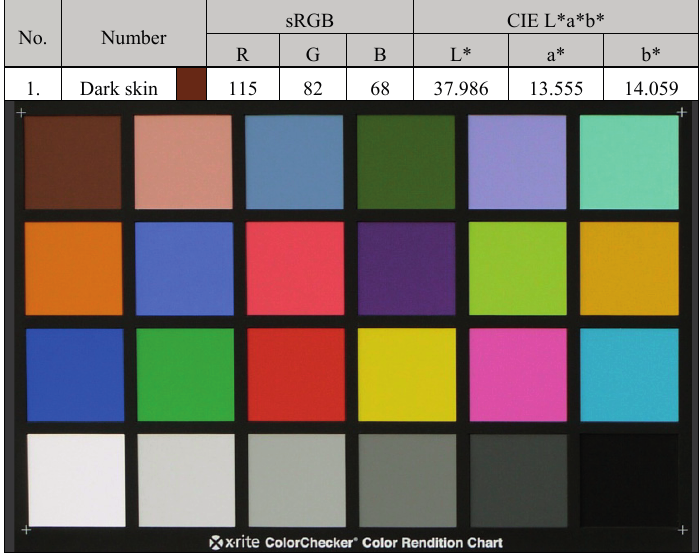
Figure 7. Chromatic chart ColorChecker and chromatic values in CIE Lab space and